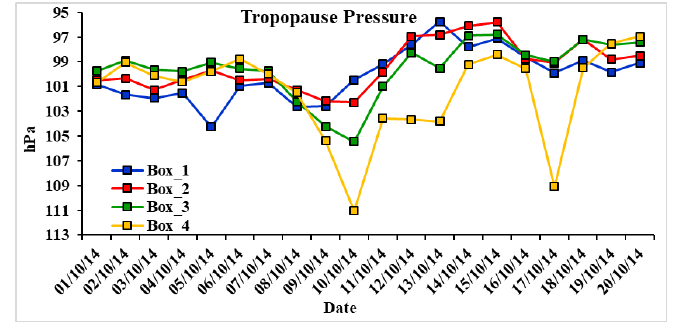
Figure 9. Temporal variation of tropopause pressure over Boxes 1, 2, 3 and 4.